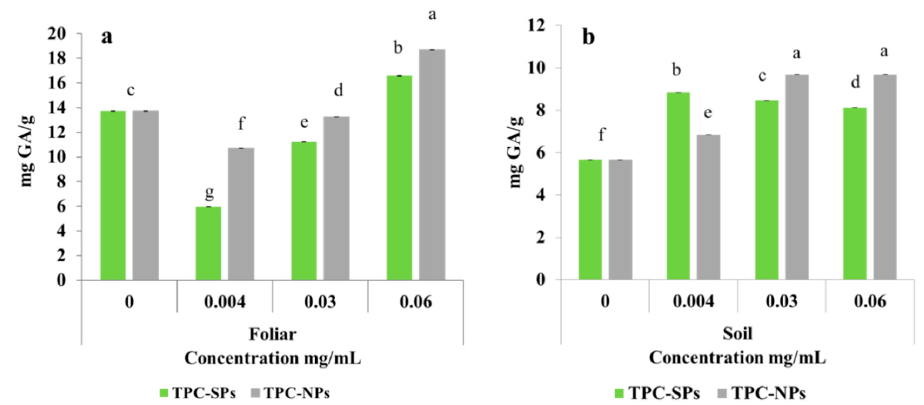
Figure 4. Total phenolic content ( a , b ) in wheat leaves upon respective foliar and soil application of SPs and Cu NPs.